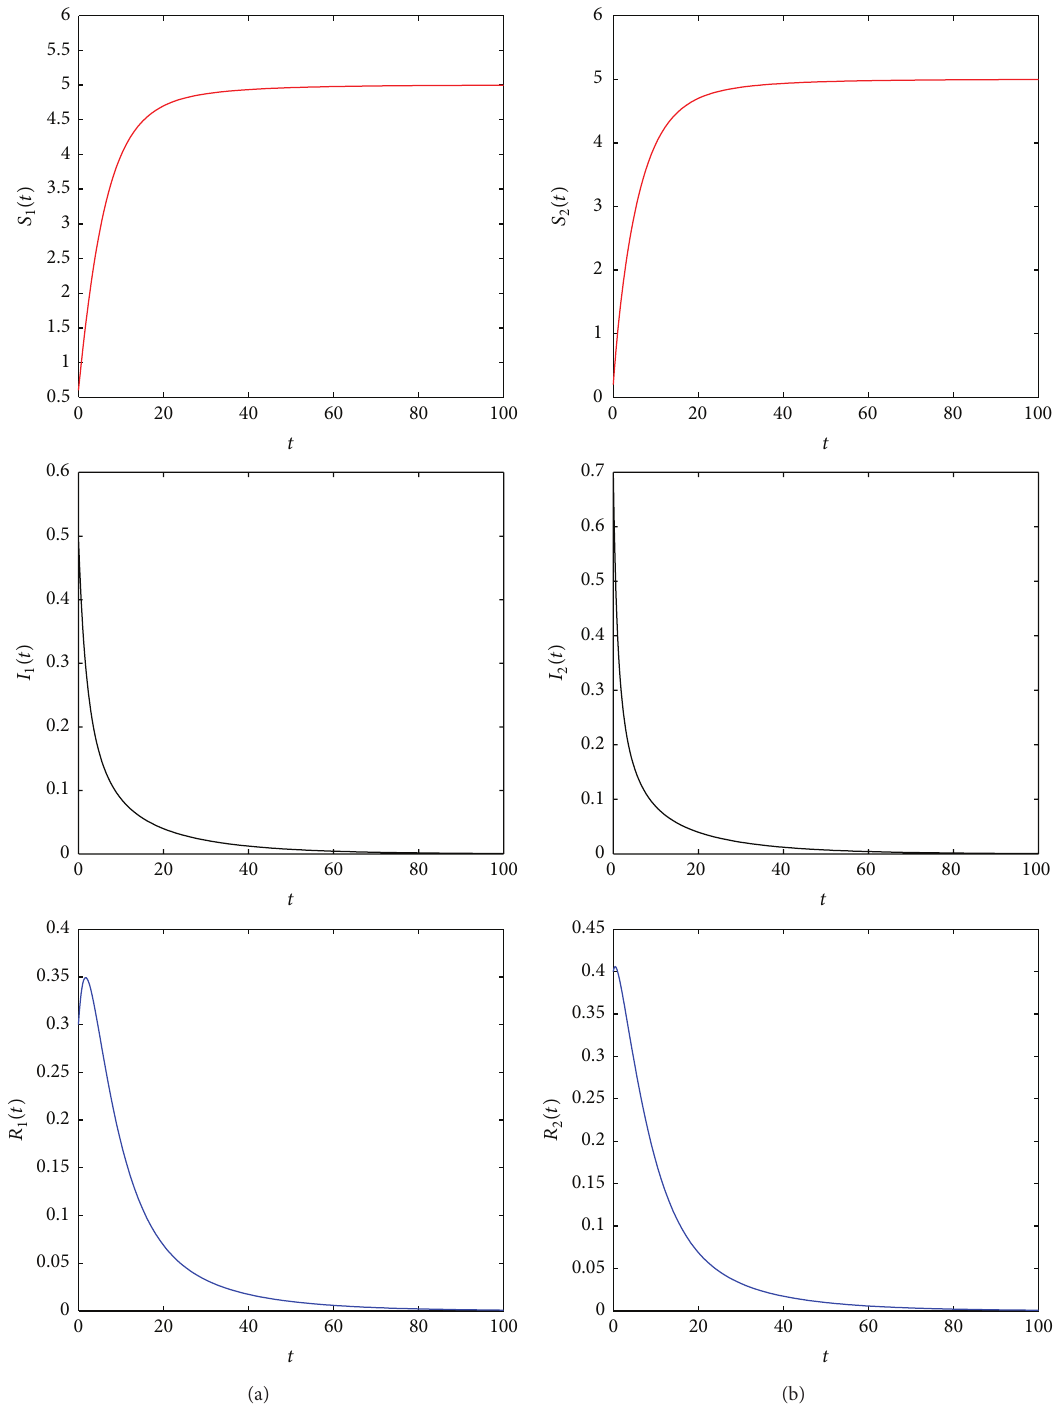
Figure 1: (a) shows movement paths of 𝑆 1 ,𝐼 1 , and 𝑅 1 as functions of time 𝑡 . (b) shows movement paths of 𝑆 2 ,𝐼 2 , and 𝑅 2 as functions of time 𝑡 . Here 𝑎 = 1 , 𝑏 = 0.2 , 𝑐 = 0.4 , 𝑑 = 0.2 , 𝛼 = 0.3 , 𝛽 = 0.6 , and 𝛾 = 0.5 . Initial data are 0.6, 0.5, 0.3, 0.2, 0.7, 0.4 .